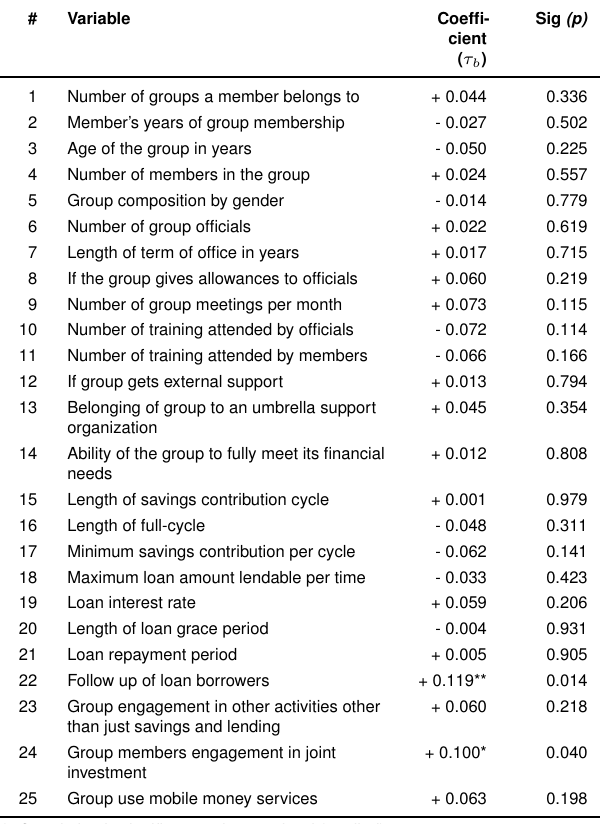
Table 9. Relationship between informal microfinance institu- tions characteristics and perception based climate variability vulnerability